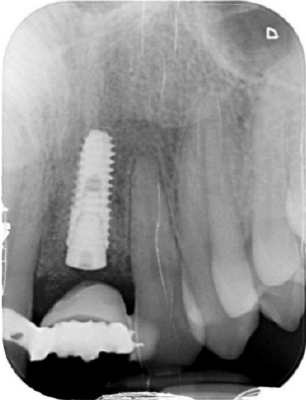
Figure 8. Implant position after guided implant placement, with minimally invasive flap elevation, and submerged healing.